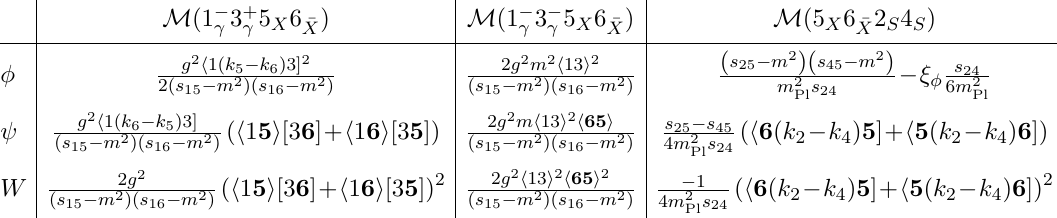
Table 1 . Amplitudes relevant in the determination of Disc F i , where g is the gauge coupling (in the normalization of unit charge). Each row corresponds respectively to X = φ,ψ,W . Other photon helicities are recovered by replacing holomorphic with anti-holomorphic configurations (and vice-versa). Notice, that all amplitudes are given in terms of incoming states, and in order to be used in (1.9) all legs on the r.h.s. of the arrows should be flipped by the map p → − p , and | p i I → −| p i I , | p ] I → | p ] I for massive legs. In this case, the overall effect of the flipping is just the lowering of the SU(2) indices on the massive legs, and no effect on the scalar legs. The contact term proportional